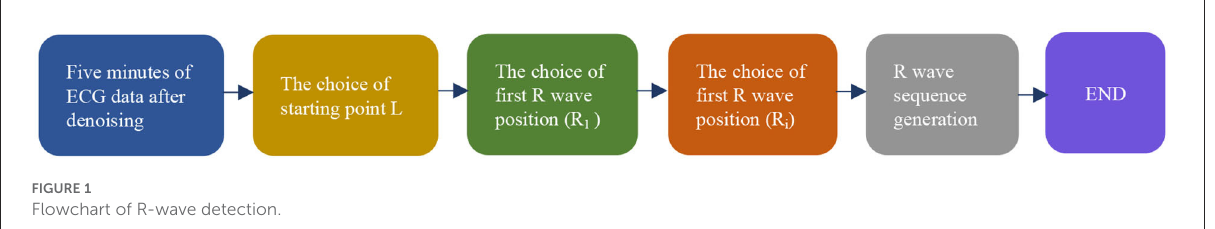
FIGURE1 Flowchart of R-wave detection.